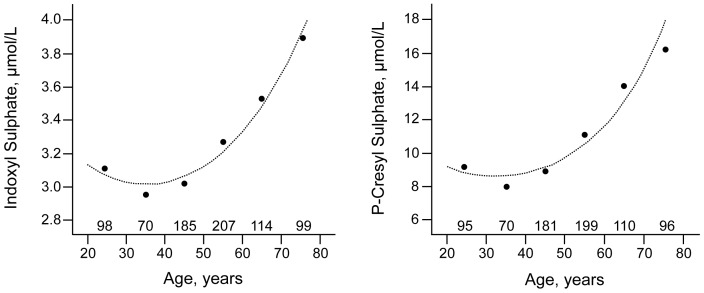
Indoxyl sulfate and p-cresyl sulfate according to age.The dots indicate the geometric means of indoxyl sulfate (IndS) and p-cresyl sulfate (PCS) in decades of age (<30 years, 30–39 years, 40–49 years, 50–59 years, 60–69 years and ≥70 years). The numbers above the horizontal axis are the number of subjects in the various age classes. The curves are calculated from a regression model with log IndS and log PCS as dependent variables and age and age-squared as independent variables. For IndS the P-values of the linear and squared terms were 0.035 and 0.0024 respectively. The corresponding P-values for PCS were 0.070 and 0.004.